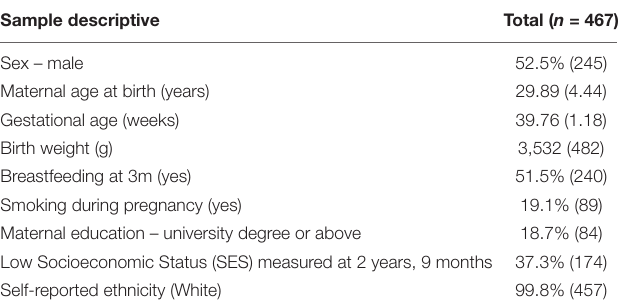
TABLE 4 | Participants’ characteristics in ALSPAC.